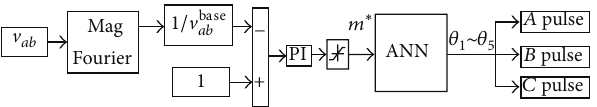
Figure 9: The proposed closed-loop control algorithm.